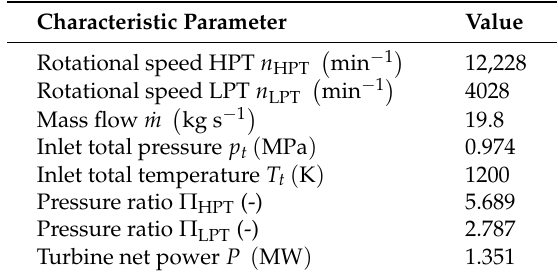
Table 6. Machine characteristics at the investigated operating point for Jet A-1. LPT, low pressure